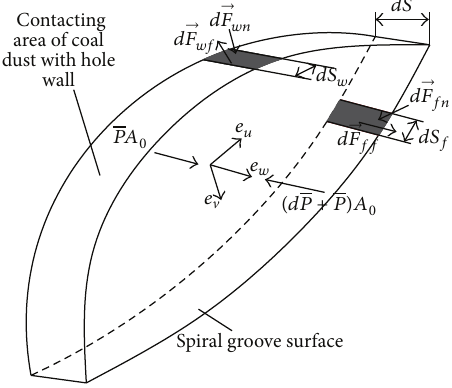
Figure 2: Mechanical mode of coal dust